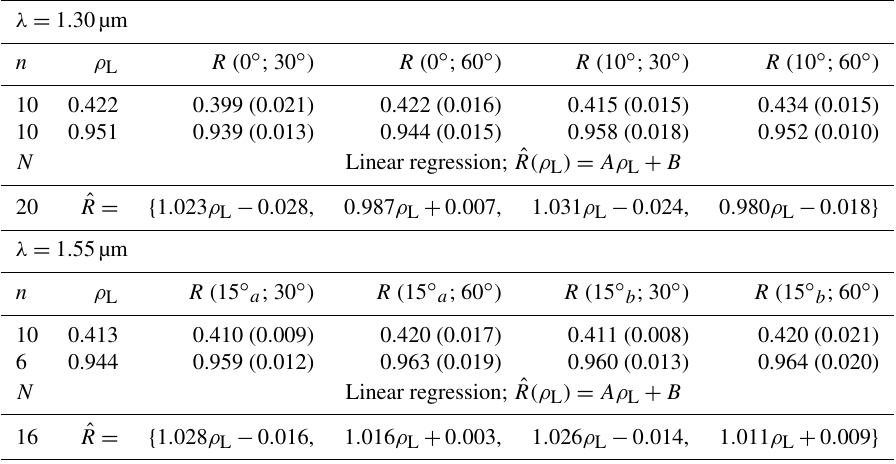
Table 1. NERD Lambertian reflectance measurements. Tabulated values represent median BRFs ( R(θ i ; θ r ) ) calculated for n samples of measurements from Lambertian reflectance targets with nominal reflectances of ρ L (rms difference in parentheses). Linear regressions for each wavelength ( λ ) are calculated from n 1 + n 2 = N